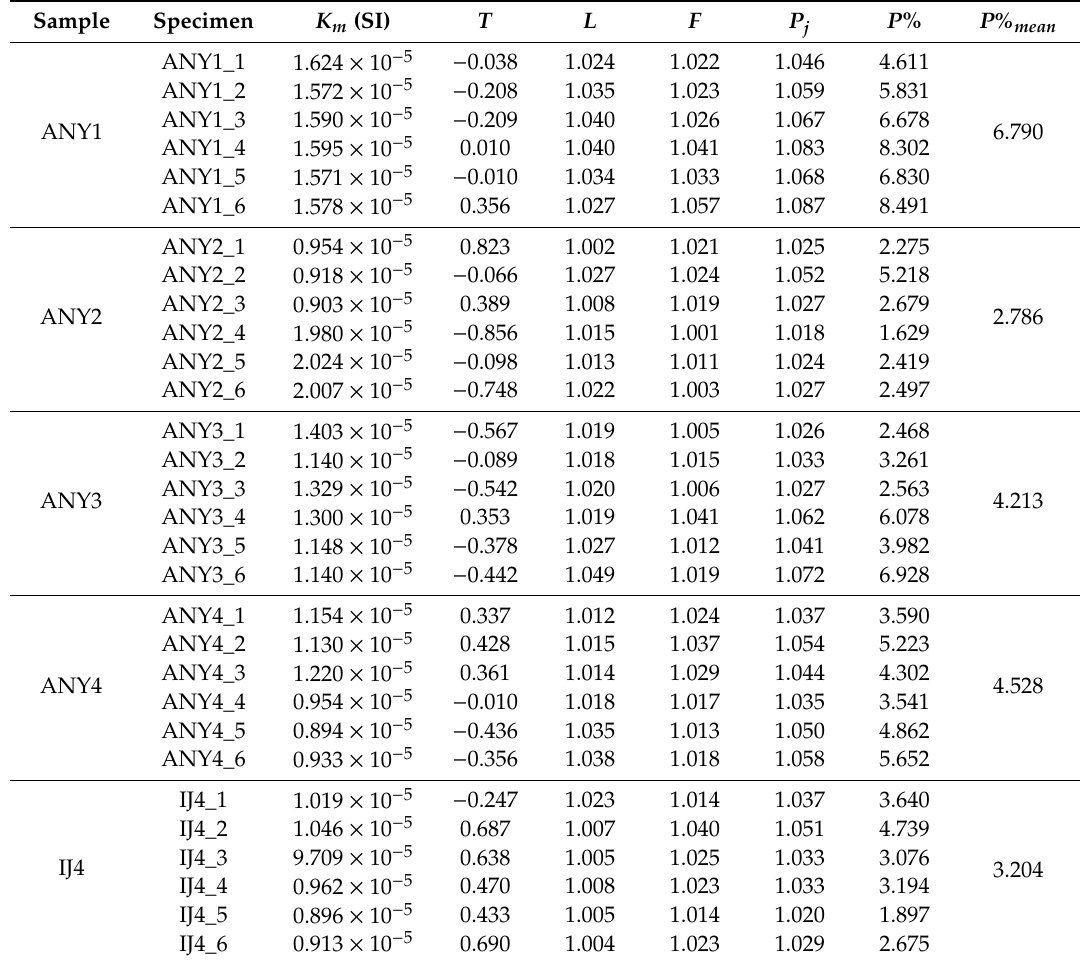
Table 2. Magnetic anisotropy parameters for all